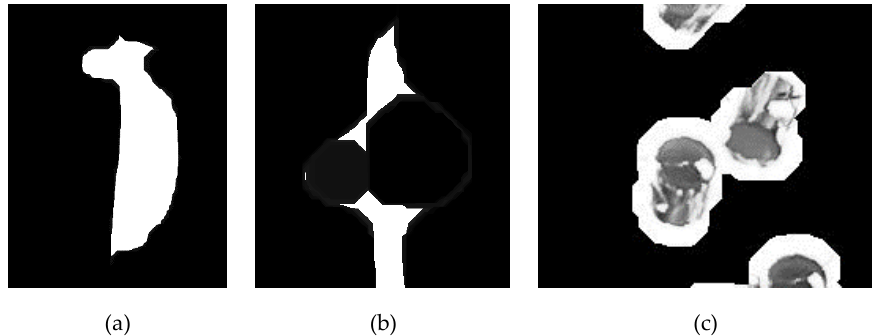
Figure 7. ( a ) Item B after morphological image closing plus image erosion; ( b ) an example of wires loop after morphological closing followed by image erosion; ( c ) clusters merged after dilation. The image is intentionally left in grayscale to show actual original items.